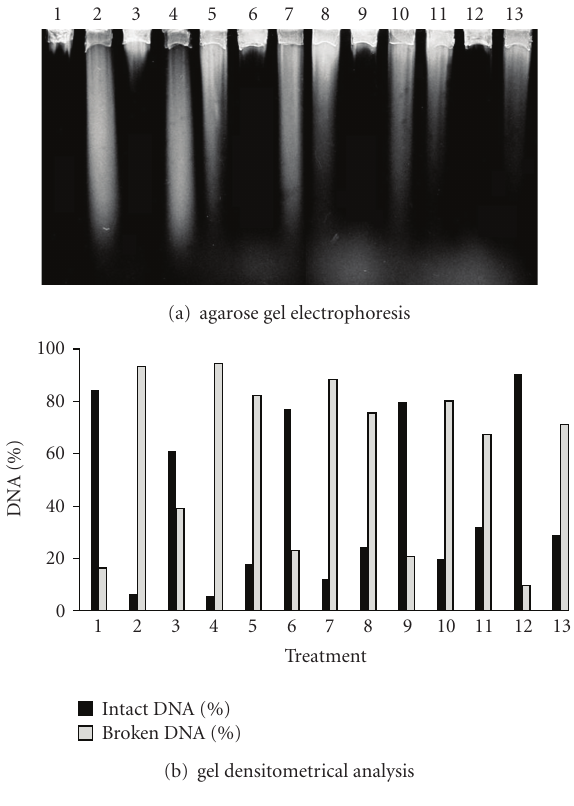
Figure 9: Alkaline gel electrophoresis of E. coli BW9091 treated with SnCl 2 (25 μ g/mL), UVA (90kJ/m 2 ), and pre-illuminated with UVA, followed by SnCl 2 incubation. Lanes: (1) control; (2) SnCl 2 ; (3) UVA; (4) UVA + SnCl 2 ; (5) SnCl 2 30 minutes; (6) UVA 30 minutes; (7) UVA + SnCl 2 30 minutes; (8) SnCl 2 60 minutes; (9) UVA 60 minutes; (10) UVA + SnCl 2 60 minutes; (11) SnCl 2 90 minutes; (12) UVA 90 minutes; (13) UVA + SnCl 2 90